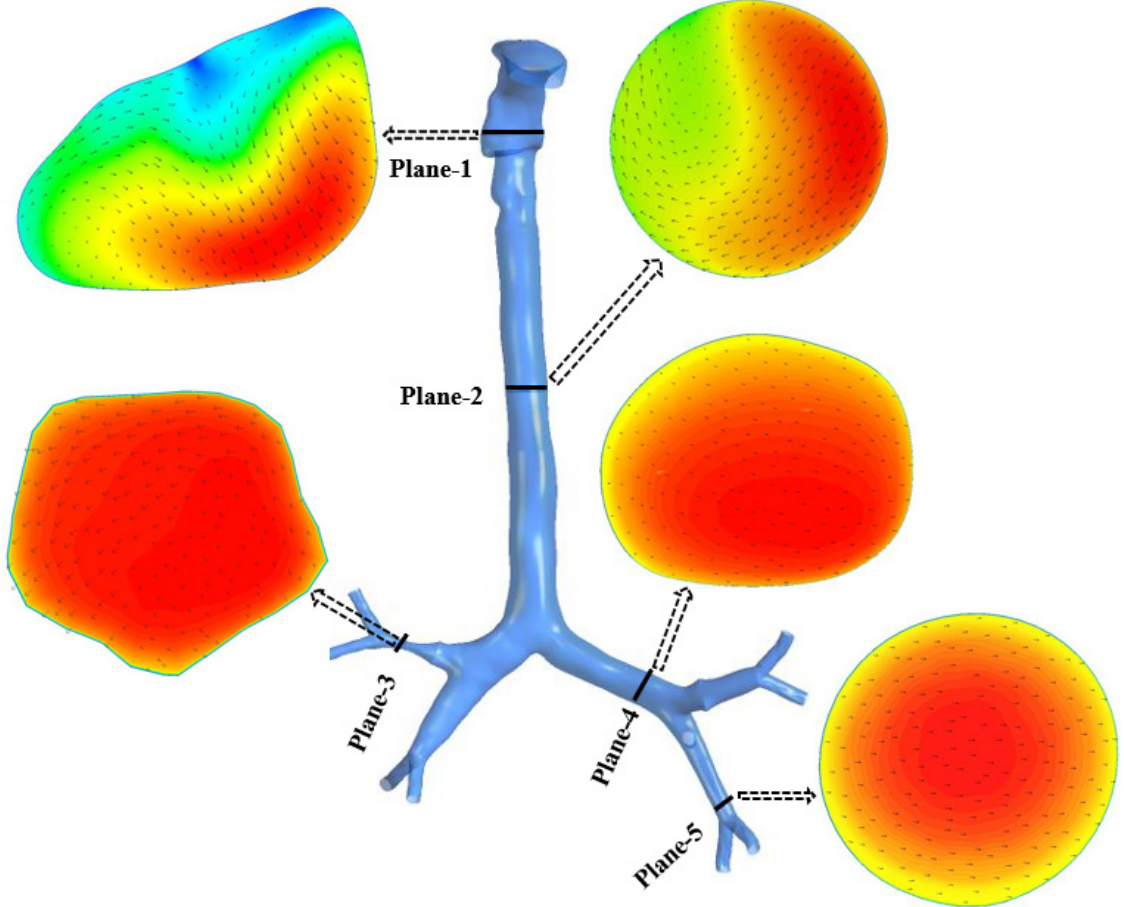
Figure 14. Velocity contours at different positions in the mouth–throat and tracheobronchial airways at a flow rate of 60 L/min.